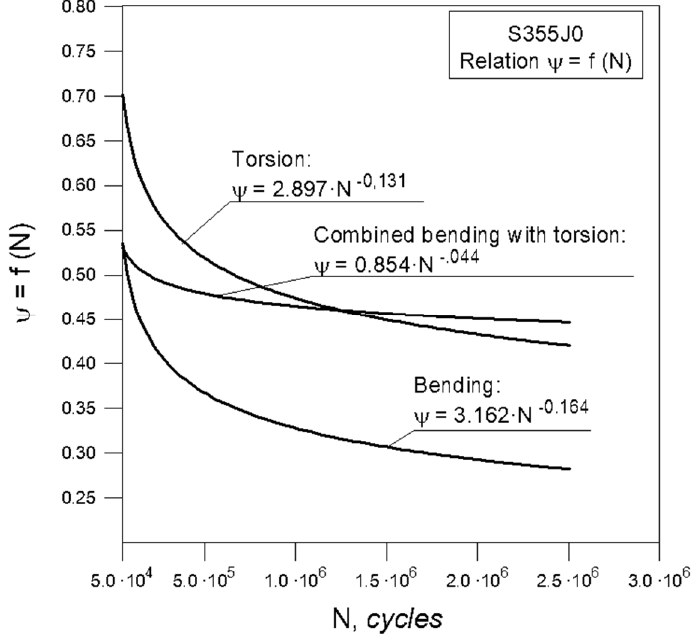
ψ = f ( N ) for the asymmetry of